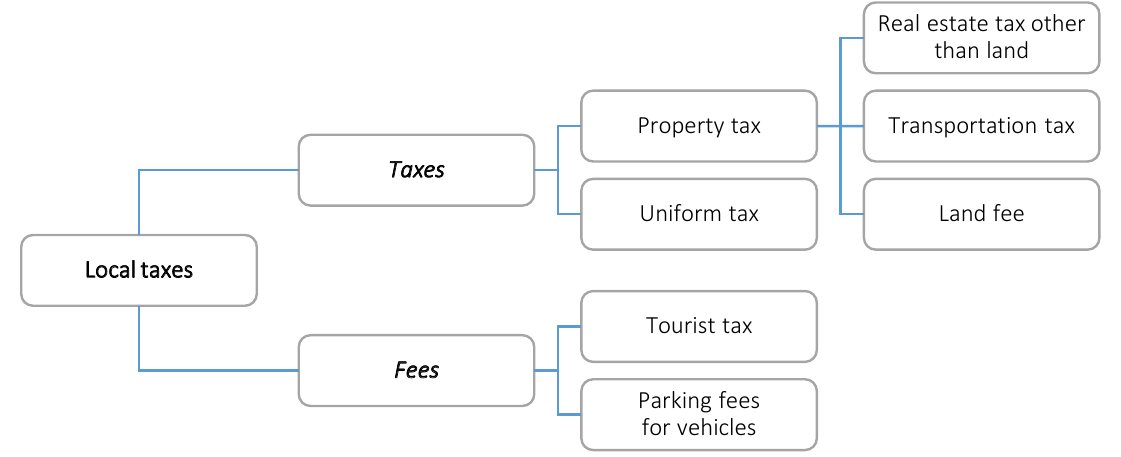
Figure 1. The structure of local taxes (fees) in Ukraine